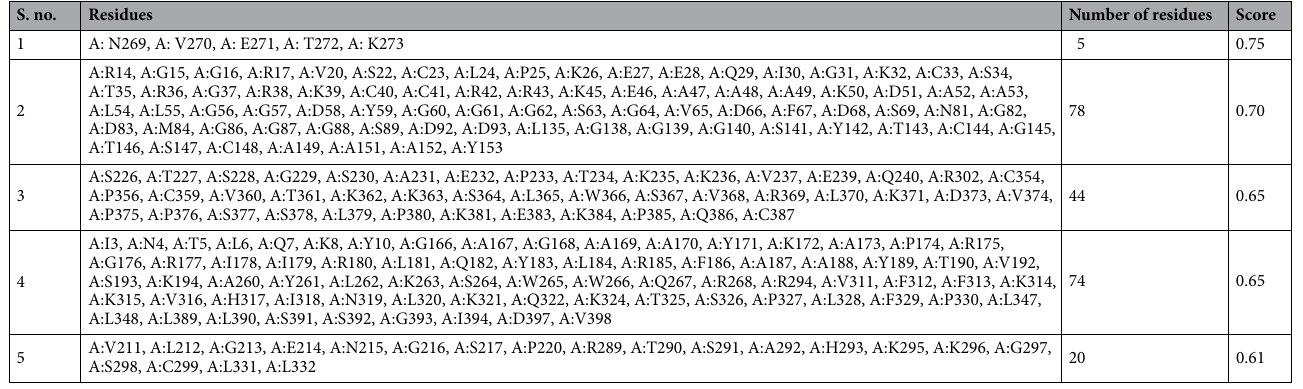
Table 9. Discontinuous B-cell epitopes predicted by the ElliPro. Two hundred and twenty-one residues were found to be located in five discontinuous B-cell epitopes of the refined vaccine